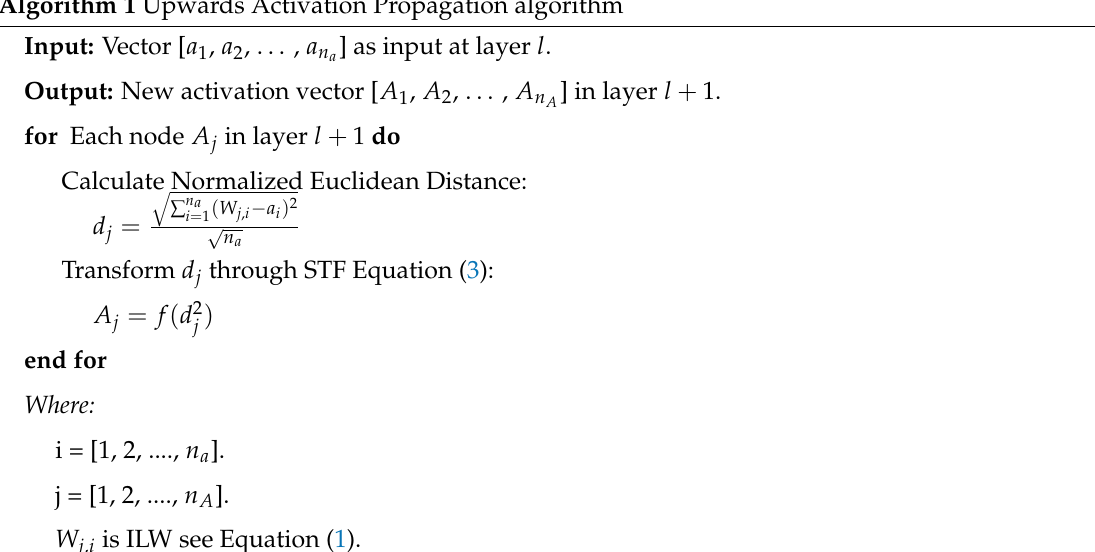
Algorithm 1 Upwards Activation Propagation algorithm